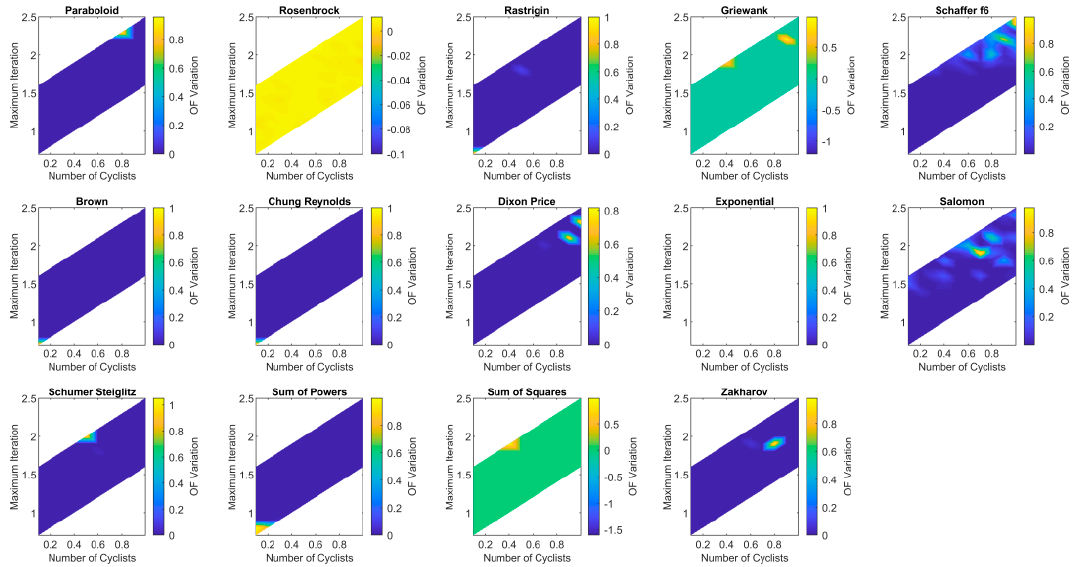
Figure 6. Sensitivity analysis for the score of parameters 𝒌 𝒈 and 𝒌 𝒅